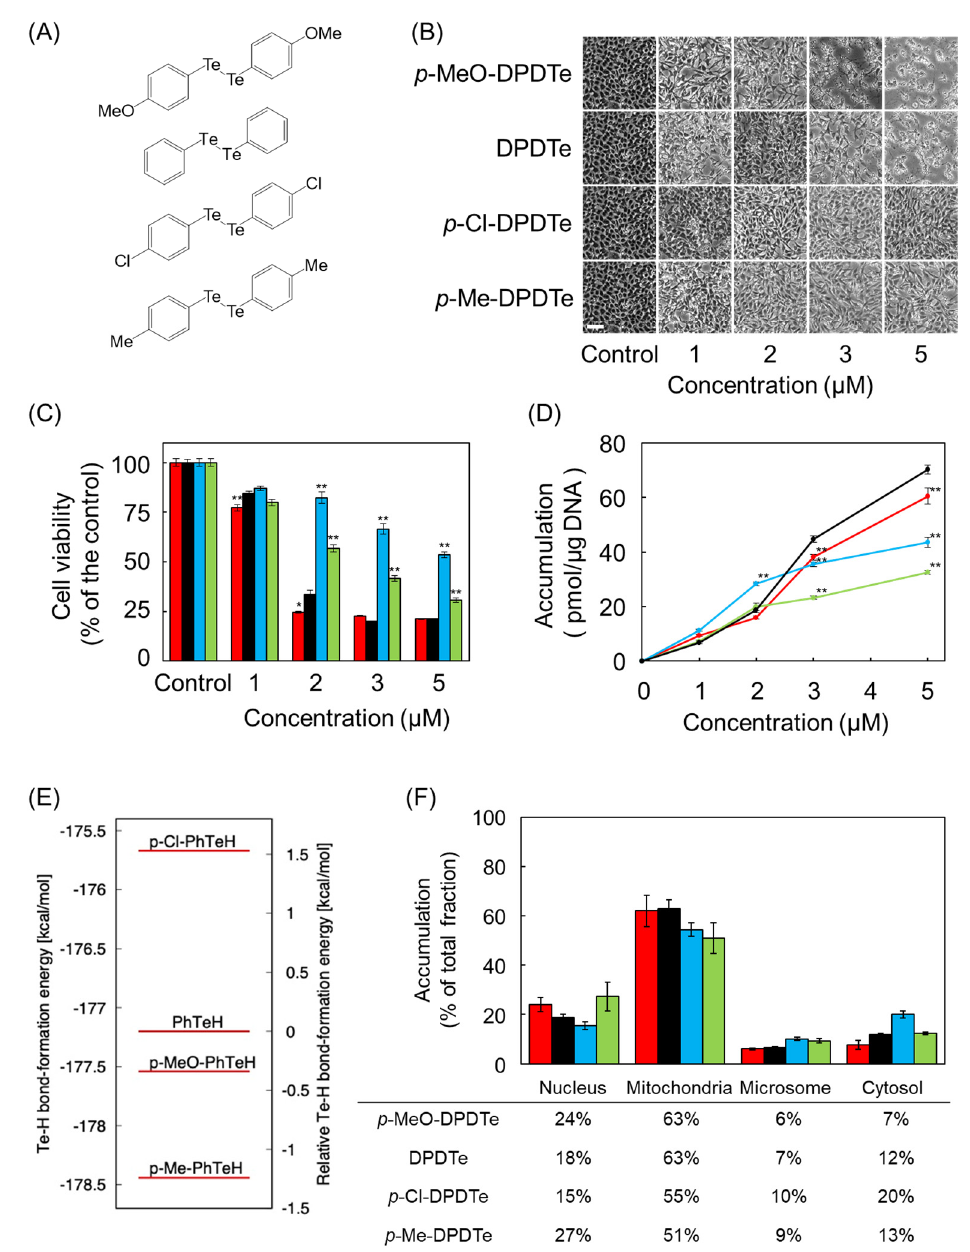
Figure 4. Effect of substitution on cytotoxicity and intracellular accumulation of DPDTe. ( A ) Structure of p -MeO-DPDTe, DPDTe, p -Cl-DPDTe, and p -Me-DPDTe. ( B ) Morphological observation (bar = 50 µ m), ( C ) viability of vascular endothelial cells, and ( D ) intracellular accumulation of p -MeO-DPDTe, DPDTe, p -Cl-DPDTe, and p -Me-DPDTe. Vascular endothelial cells were treated with p -MeO-DPDTe (red), DPDTe (black), p -Cl-DPDTe (blue), and p -Me-DPDTe (green) (1, 2, 3, or 5 µ M) for 24 h. ( E ) Te–H bond formation energies in p -MeO-PhTeH, PhTeH, p -Cl-PhTeH, and p -Me-PhTeH. ( F ) Accumulation of p -MeO-DPDTe, DPDTe, p -Cl-DPDTe, and p -Me-DPDTe in cellular fractions. Vascular endothelial cells were treated with 2 µ M of p -MeO-DPDTe (red), DPDTe (black), p -Cl-DPDTe (blue), and p -Me-DPDTe (green) for 24 h. Values are expressed as the mean ± standard error of three replicates. * p < 0.05, ** p < 0.01 compared with the corresponding DPDTe treatment.